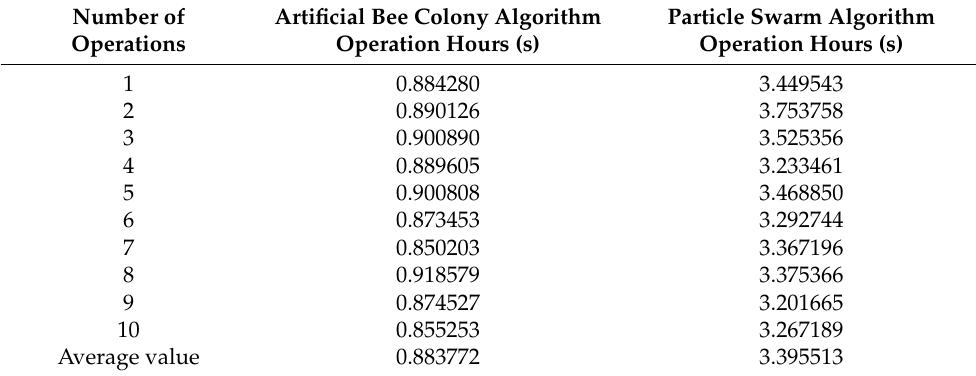
Table 10. Simulation run time.